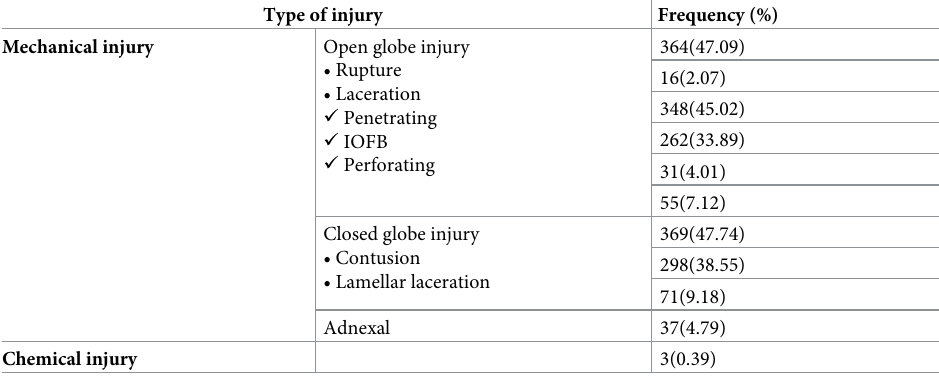
Table 1. Types of ocular injury in patients treated at Hawassa University, Referral Hospital, from January 01, 2012 to July 31, 2014 (N =